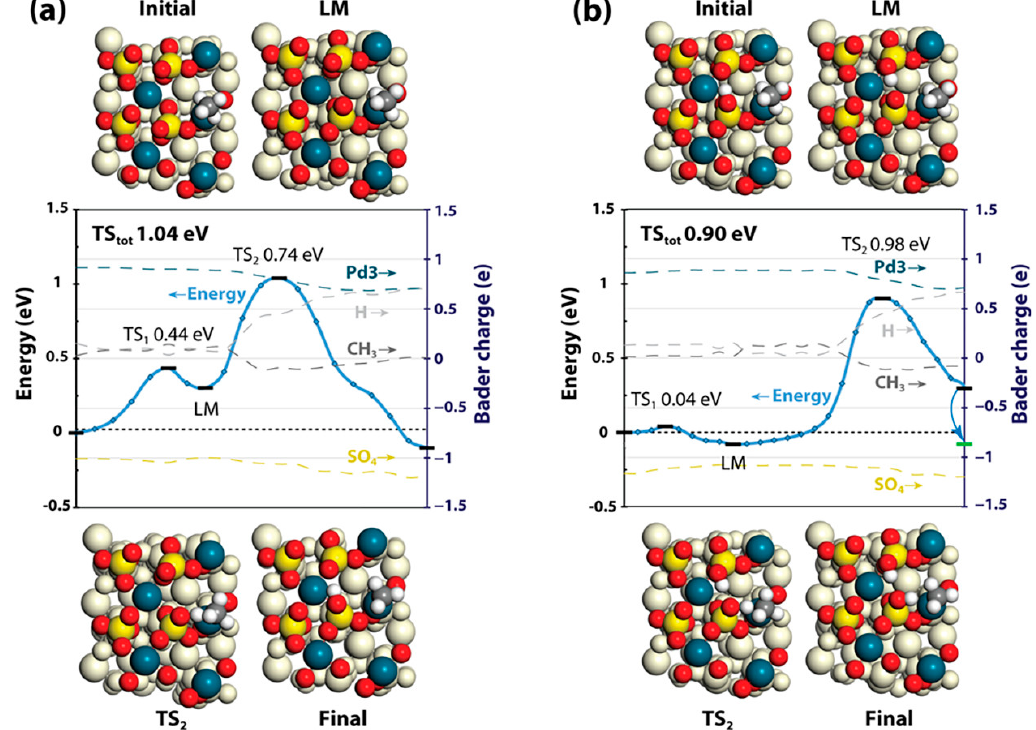
Figure 16. Energy profiles (solid line) predicted by the NEB and the associated Bader charges (dashed lines) for dissociation of methane to the S 2 position on ( a ) a clean PdSO 4 (111) surface and ( b ) a hydroxylated PdSO 4 (111) surface. The black bars on the energy curve denote minimum and TS structures, whereas small diamonds denote NEB images. The green bar in ( b ) denotes the energy of the final structure with reoriented hydroxyl groups. Negative Bader charge corresponds to an excess of electrons relative to isolated atoms, whereas positive Bader charge corresponds to the deficiency of electrons. Reprinted with permission from Ref. [110]. Copyright 2020, copyright American Chem- ical Society.